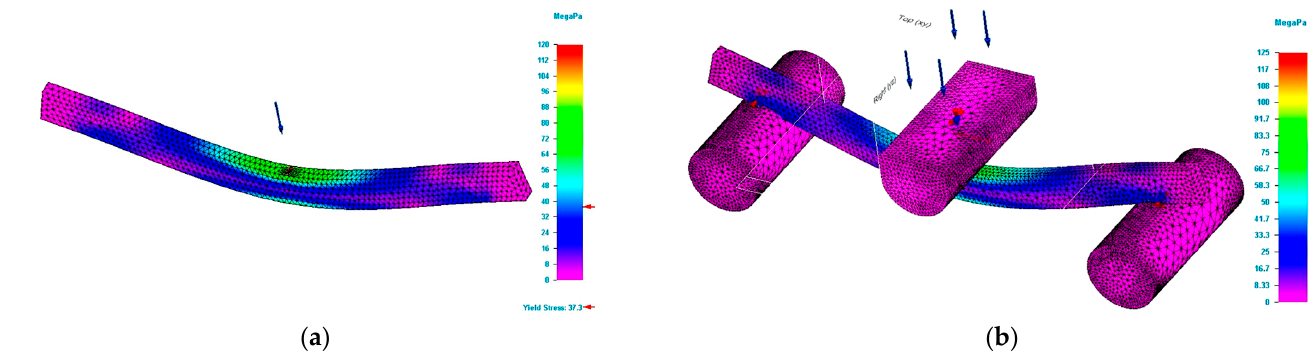
Figure 8. Result of simulation process for P_R15 specimen (Von Mises stress). ( a ) Von Mises stress for simple modelling. ( b ) Von Mises stress for complex modelling.